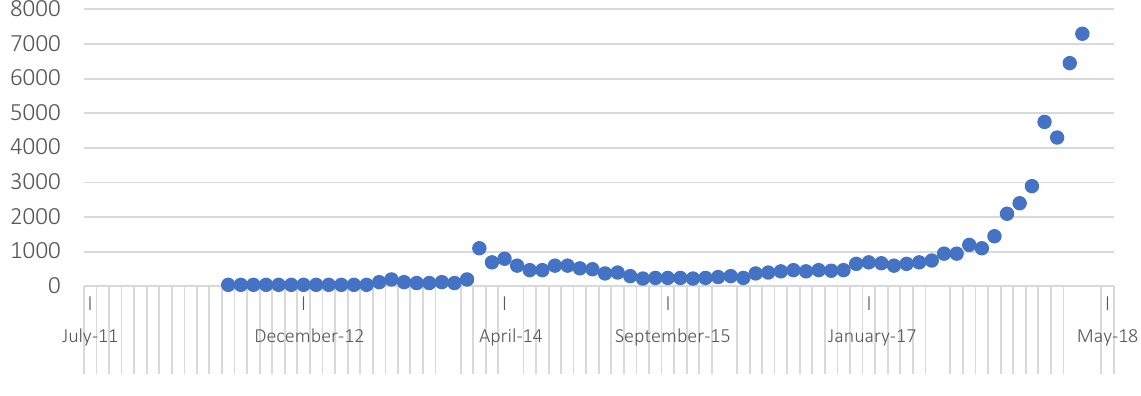
Figure 4. Trends of